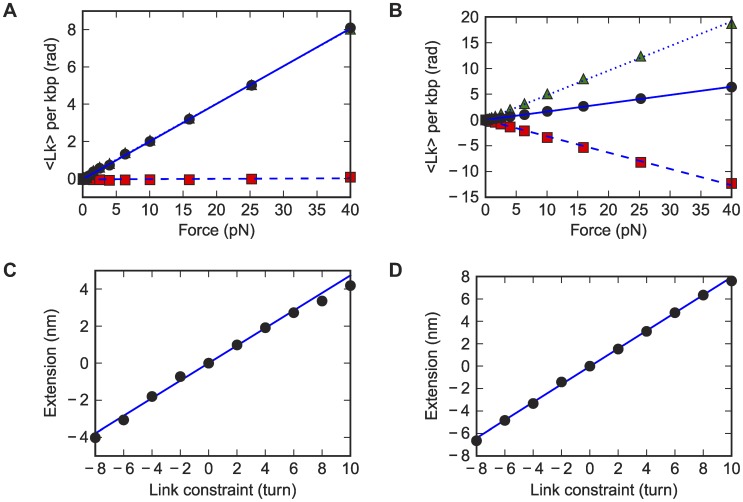
Link-extension coupling constants from the simulations.(A, C) DNA_default. (B, D) RNA_default. (A, B) Link per kbp vs. force plot (black dots) with a linear fit (blue solid lines). The link values are offset such that the first point (at 0.04 pN stretching force) has a link of zero. The corresponding twist (green triangles) and writhe (red squares) component for each link data point, as well as linear fits (dotted and dashed lines) are also shown in the figures. In panel A, the writhe is close to zero, and the link and twist are almost undistinguishable. (C, D) Extension vs. target link constraint in link-constrained simulations with linear fits, at 7 pN stretching forces. The first and last data points are not used for fitting as the linear relationship breaks down at high numbers of turns.